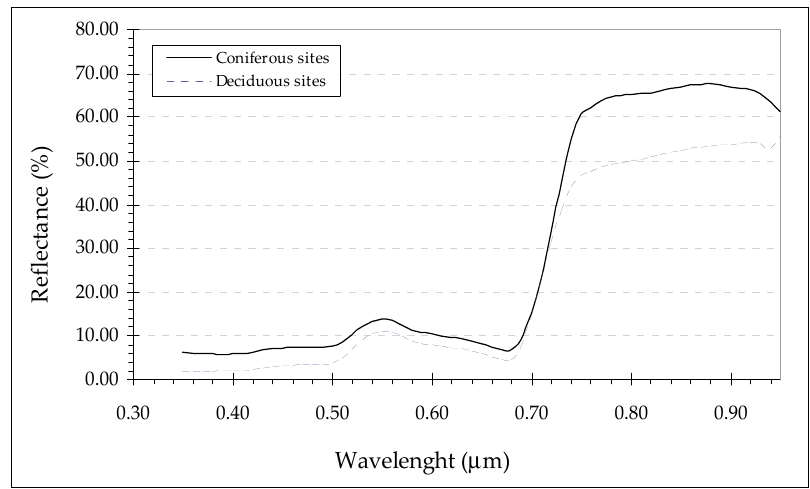
Figure A1. Typical understory spectral reflectance in Kananaskis Field Station study sites during the summer of 2003.